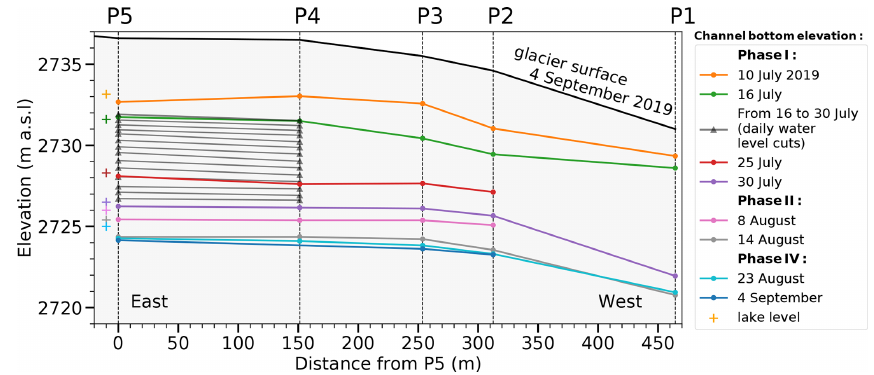
Figure 3. Channel bottom elevation at P5, P4, P3, P2 and P1 during the lake drainage (locations are presented in Fig. 1). The colour-coded crosses indicate the lake level at the corresponding time. Note that the actual lake was located further east than P5. Distances between stations are taken along the channel flow path.